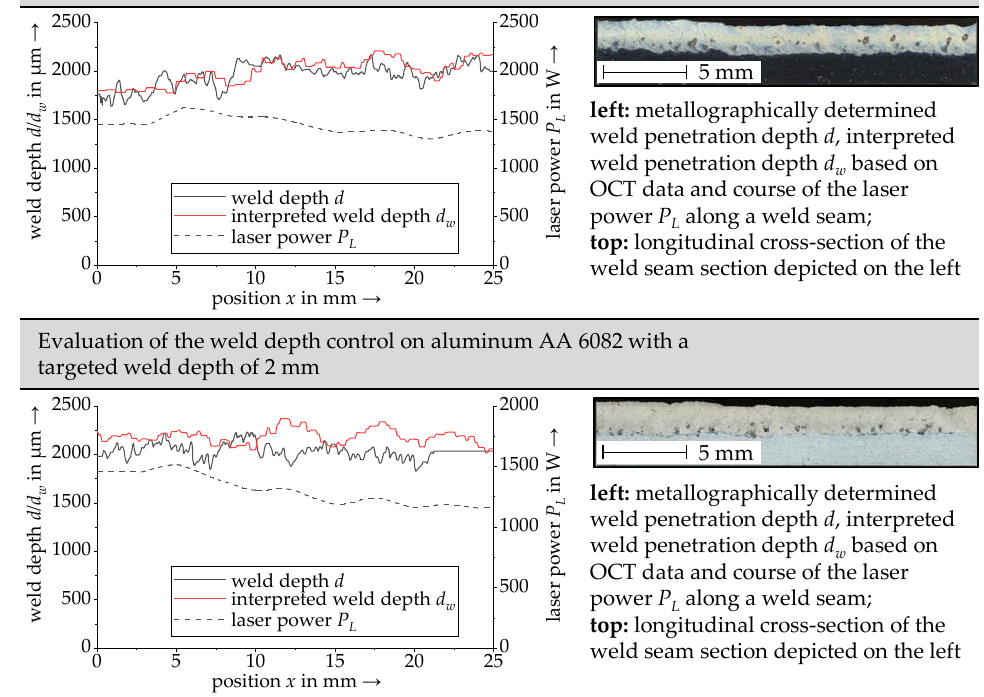
power P along a weld seam; L top: longitudinal cross-section of the weld seam section depicted on the left